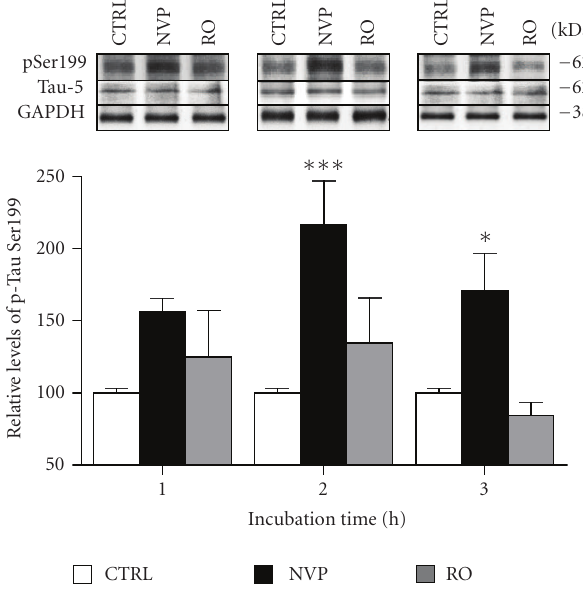
Figure 1: Blockade of NR2A-containing NMDA receptors induces Tau phosphorylation at Ser199 site in rat hippocampal slices. Phosphorylation and protein levels were estimated by Western blotting on cell extracts (40 μ g proteins) obtained from acute hippocampal slices treated with 2NMDA receptor antagonists for periods ranging from 1 to 3 hours. Phosphorylated Tau levels at Ser199, expressed relative to total Tau (Tau-5) levels, were measured in slices treated with 50 nM NVP and 1 μ M RO. The data were expressed as percentage of control values and are means ± SEM of 3 measurements per cell extract obtained from 7 di ff erent rats. Statistical analysis using two-way ANOVA followed by the post hoc Bonferroni test revealed that there was a main e ff ect between treatment (F(2,54) = 16.370, P < . 0001), no e ff ect between time (F(2,54) = 2.509, P = . 091) and no significant interaction between treatment and time (F(4,54) = 1.337, P = . 268). ∗ P < . 05, ∗∗∗ P < . 001, drug-treated versus